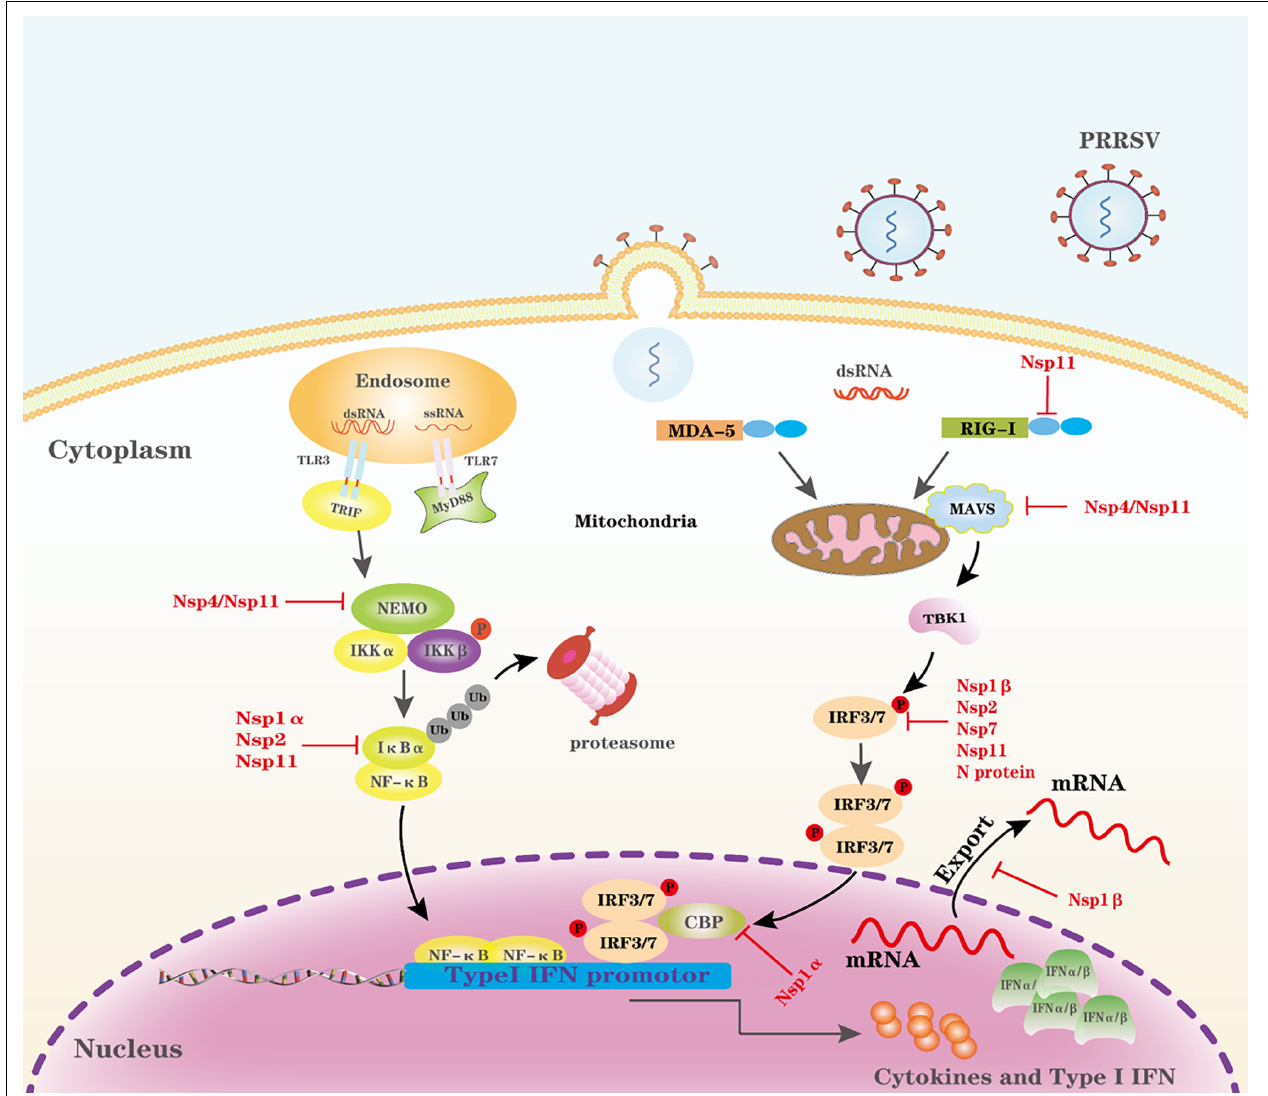
FIGURE 1 | Evasion of the PRR-mediated IFN-I signal pathway by PRRSV. Cytosolic RNA sensors, such as TLR3, TLR7, RIG-1, and MDA-5, recognize PRRSV RNA in the cytosol and trigger IFN-I production by transmitting a series of signals. PRRSV proteins can target multiple steps in the RLR-mediated IFN-I signal pathway. CBP, CREB-binding protein; P, phosphate; Ub,